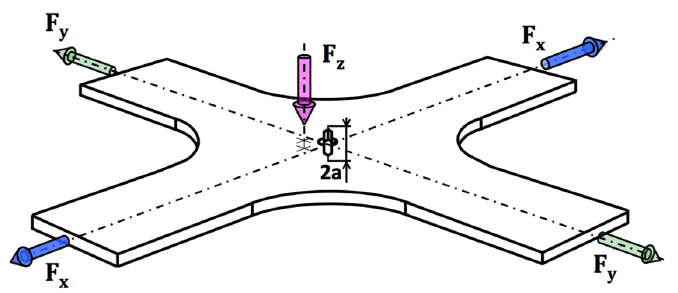
Figure 2: Schematics of the specimen and of the boundary